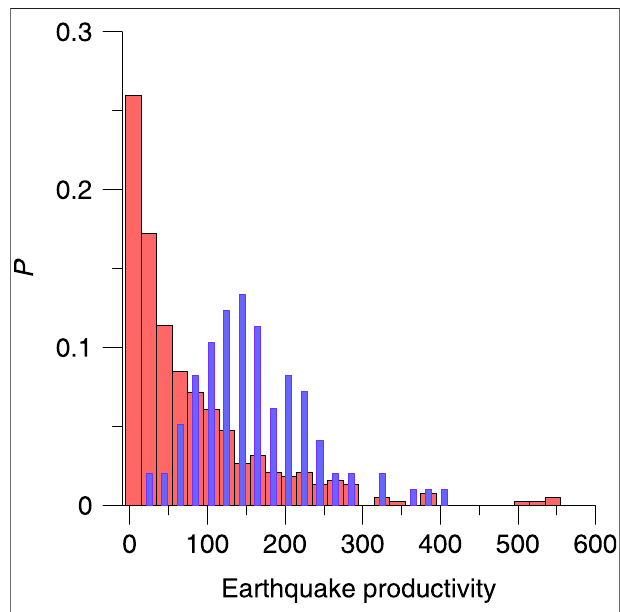
FIGURE 4 | Productivity distribution for background events (blue histogram) compared to productivity distribution for clustered events (red